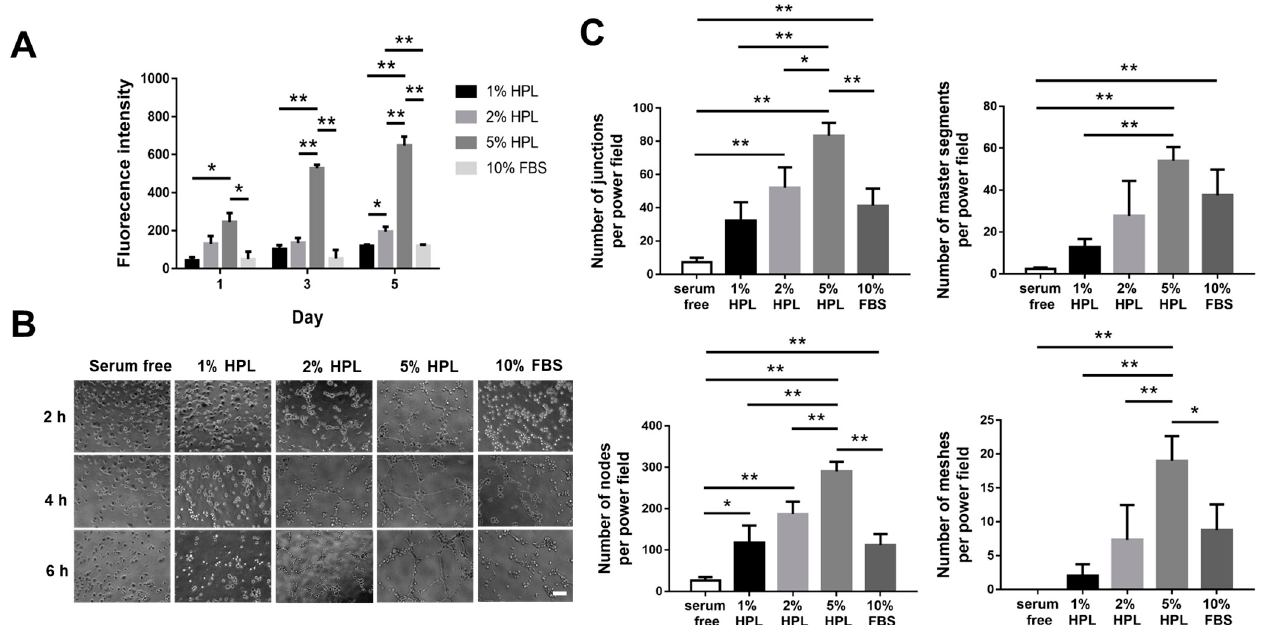
Figure 2. The influence of different concentrations of HPL on the proliferation and tube formation of HUVECs. ( A ) Alamar Blue assay revealed the proliferative activity of HUVECs incubated in different concentrations of HPL or 10% FBS. ( B ) The representative images of endothelial cell tube formation under different conditions at 2, 4 and 6 h (scale bar = 100 µ m). ( C ) The number of junctions, master segments, nodes and meshes at 4 h was compared among different groups. Serum-free was used as the control group. (* p < 0.05, ** p < 0.01). Table 1. Gelation time of CS-GE hydrogel crosslinked with different glyoxal concentrations.